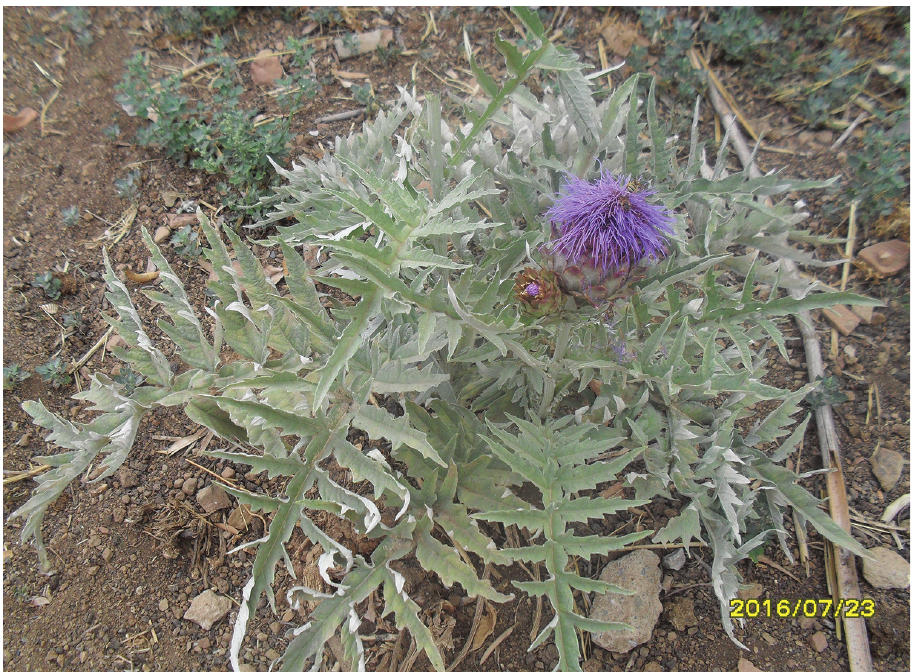
Figure 6. Cynara cardunculus L. host plant of Terellia sp. near longicauda